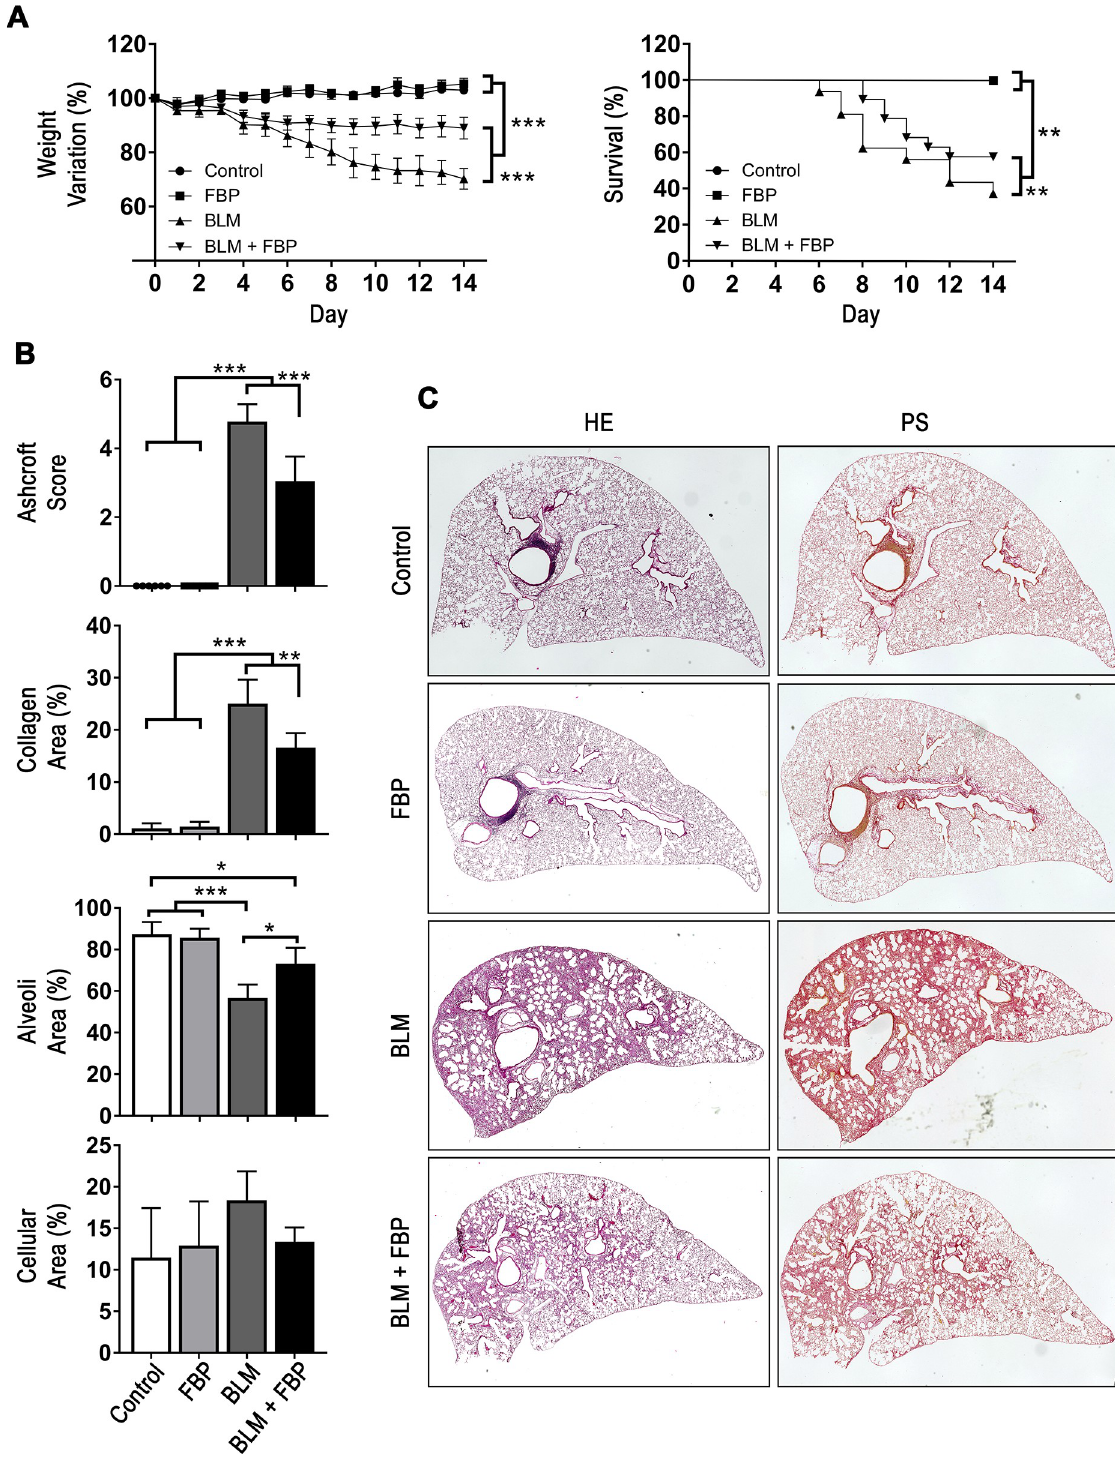
Fig 1. Fructose-1,6-bisphosphate prevents pulmonary fibrosis development and collagen deposition in the lungs. (A) Body weight variation (%) and survival rate (%) are shown during 14 days post-BLM treatment. (B) Ashcroft modified score was used to quantify fibrosis and architecture distortion degree while morphometric analysis was performed to assess area of collagen deposition in the lungs after BLM intratracheal administration and FBP treatment. (C) Representative images of lung sections stained with hematoxylin and eosin (HE) or Picro Sirius Red (PS) showing a high parenchyma distortion and collagen content in the lung after BLM administration. Treatment with FBP